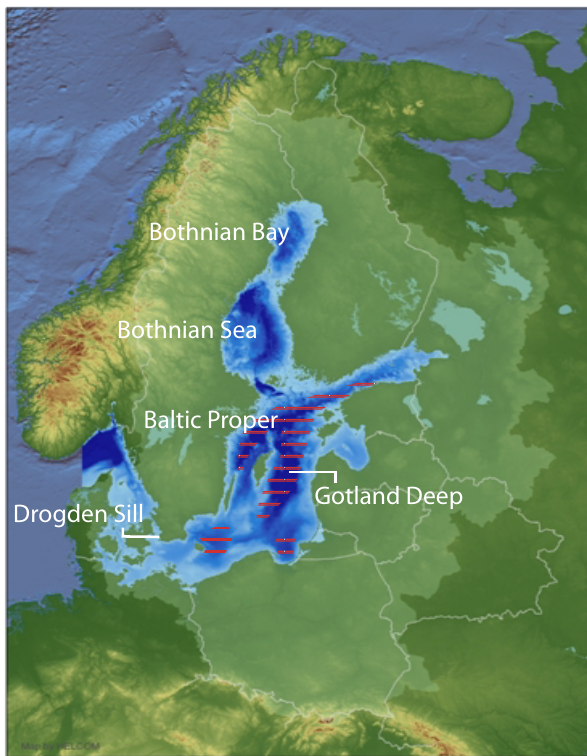
Fig. 1. Map of the Baltic Sea identifying its major sub-basins (Both- nian Bay, Bothnian Sea and Baltic Proper) and the major sill in the inlet area (Drogden Sill). The red lines designate the maxi- mum hypoxic area that occurs in the Baltic Sea. Hypoxia is com- mon in the deeper basins of the Baltic Proper where a permanent restricts the ventilation of the deeper waters and supports the de- velopment of persistent hypoxia (Conley et al., 2009a). The low salinity waters of the Bothnian Sea and, in particular, the Bothnian Bay have weaker haloclines and better ventilation. In combination with a lower productivity this better ventilation makes these basins mostly oxic. Also, the Baltic Sea drainage area in light green, where 85million people live